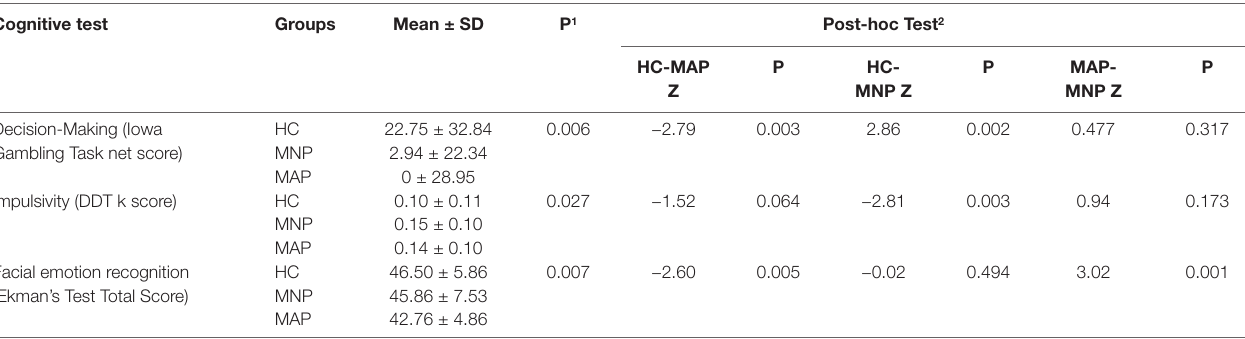
TaBlE 2 | Cognitive performance across